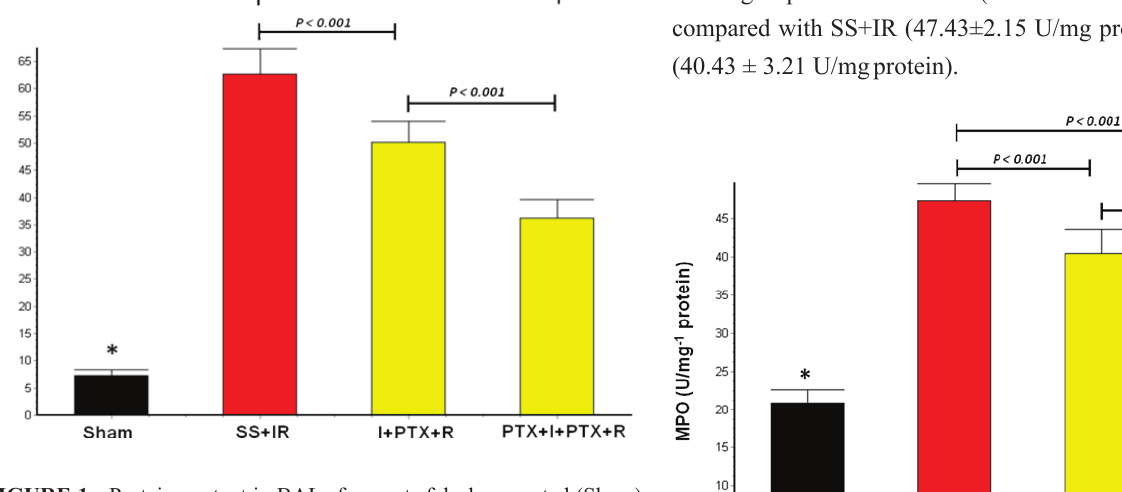
FIGURE 1 - Protein content in BALs from rats falsely operated (Sham) or subjected to mesenteric artery clamping for intestinal ischemia during 60 min, followed by clamp release for a 120-min period of reperfusion (IR). Control IR rats were treated i.v. with 0.1 mL saline solution (group SS+IR). Other IR rats were treated with pentoxifylline (PTX): group I+PTX+R received i.v. 25 mg/kg of PTX 5 min before starting the reperfusion period; the group PTX+I+PTX+R received i.v. three doses of PTX: one 5 min before ischemia, a second one 5 min before starting reperfusion, and a third one at the 60th min of reperfusion. Data are mean ± SD. * P <0.001 compared with all other groups.